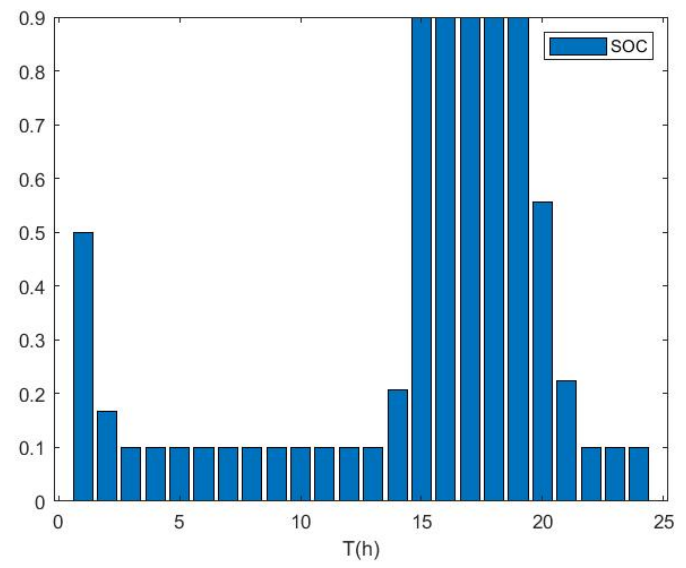
Figure 7. Battery state of charge.